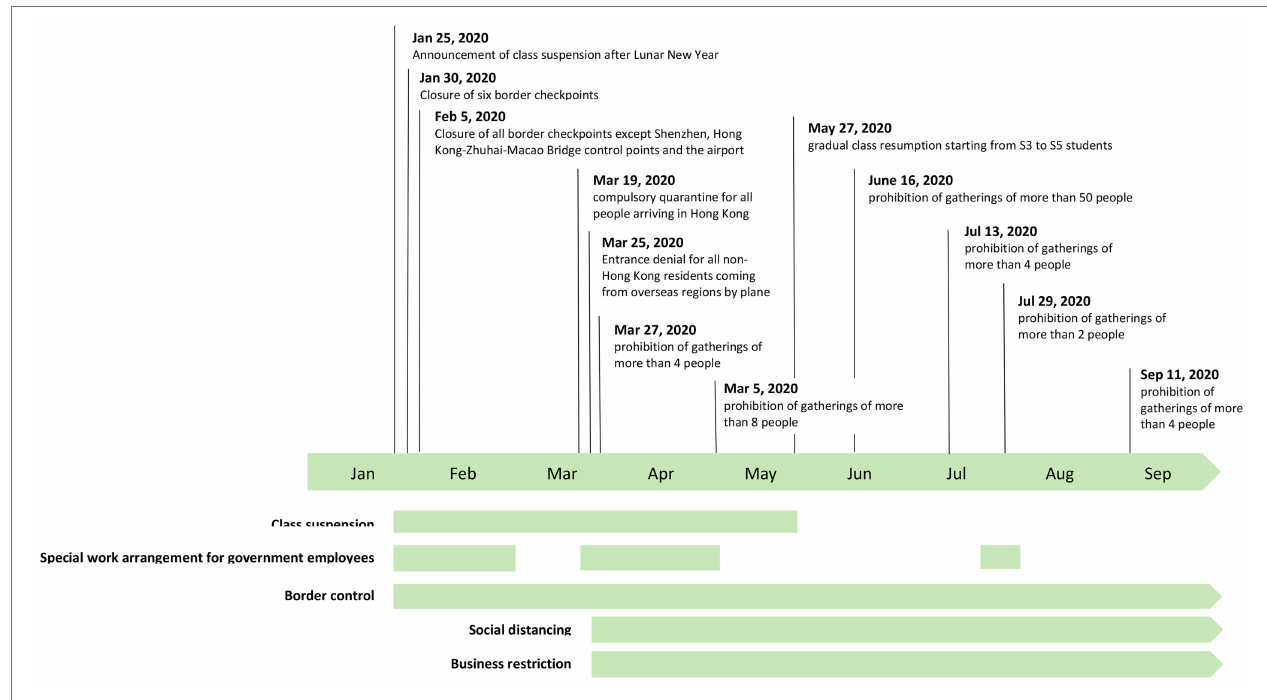
FIGURE 1 | Chronology of major events of COVID-19 control in Hong